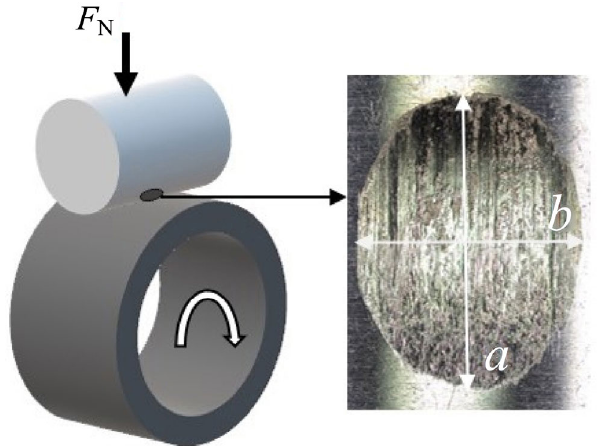
Fig. 1 Schematic representations of the contact configuration of the Brugger tribometer (left) and an elliptical wear scar (on cylinder) indicating the major and minor axes a and b